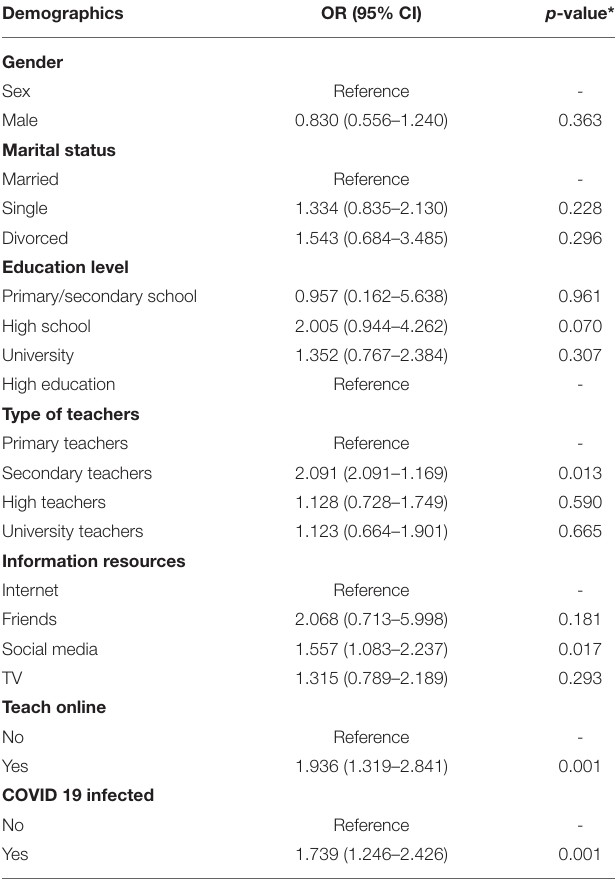
TABLE 2 | Association between participants responses with presence of